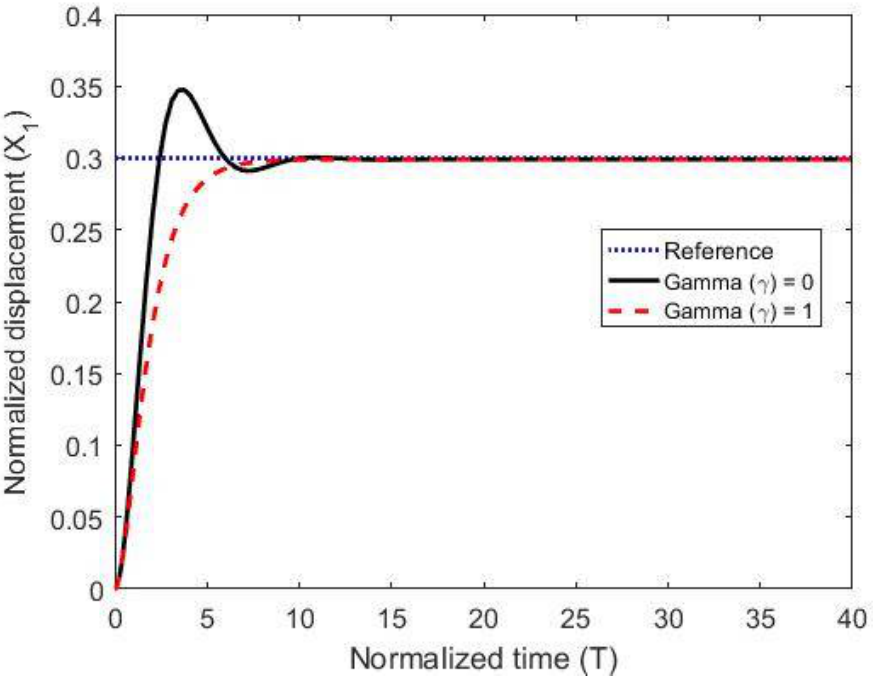
Figure 3. The normalized displacement with and without the coupling constant at a gap distance of 0.3.